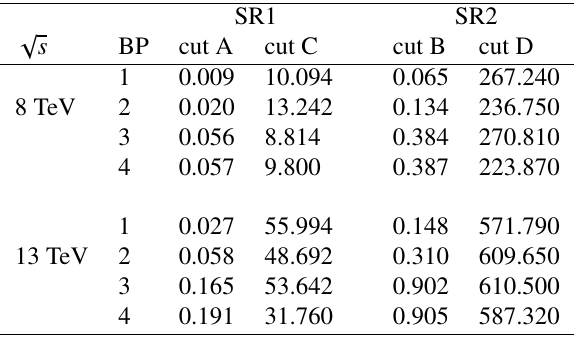
µ + µ − b ¯ b in fb → SR1 SR2